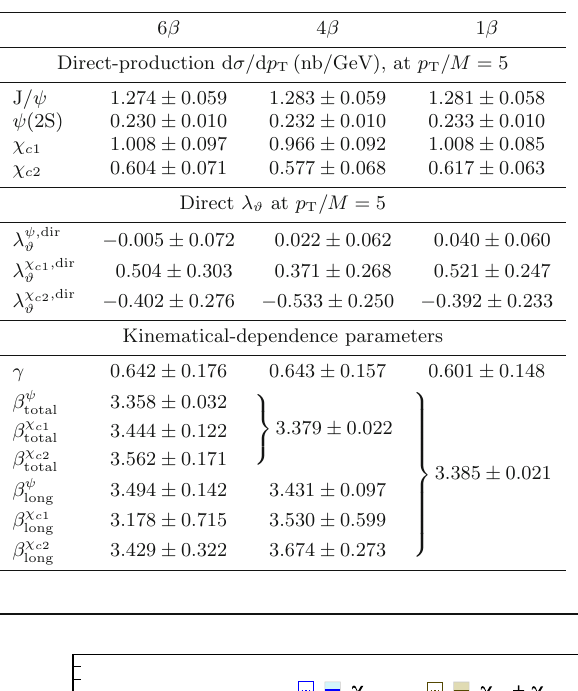
Table 2 Values of the fitted parameters of interest, in the three consid- ered scenarios